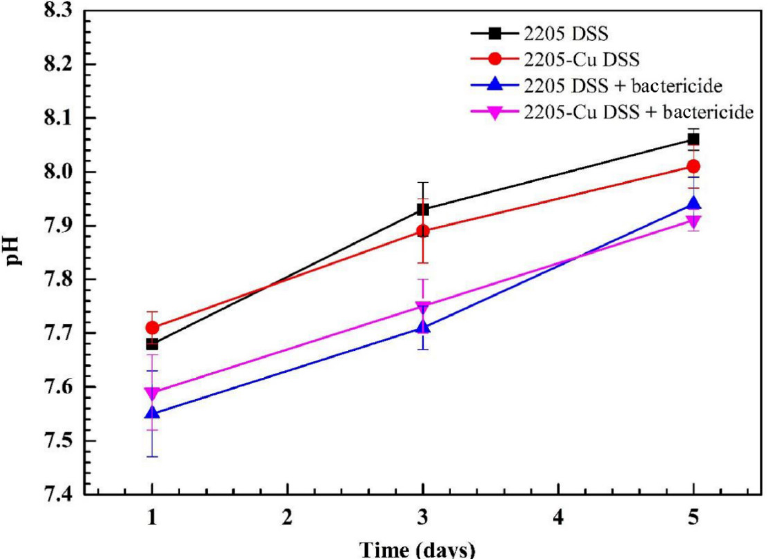
Figure 1. The pH values in different groups in the presence of P. aeruginosa . The bactericide is benzalkonium bromide. ( n = 3).